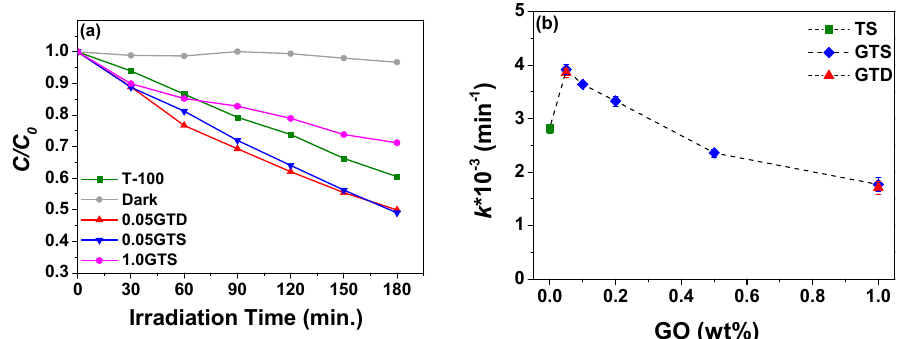
Figure 7. ( a ) Phenol degradation under sun simulator of TiO 2 and GT composites via dynamic and statistic synthesis; and ( b ) k constant of di ff erence amount of GO to TiO 2 . Vertical bars indicate error in the fitting of the data in Figure 1a with a pseudo-first order kinetic function. Standard deviation of k values measured on three kinetic tests were smaller than error bars.